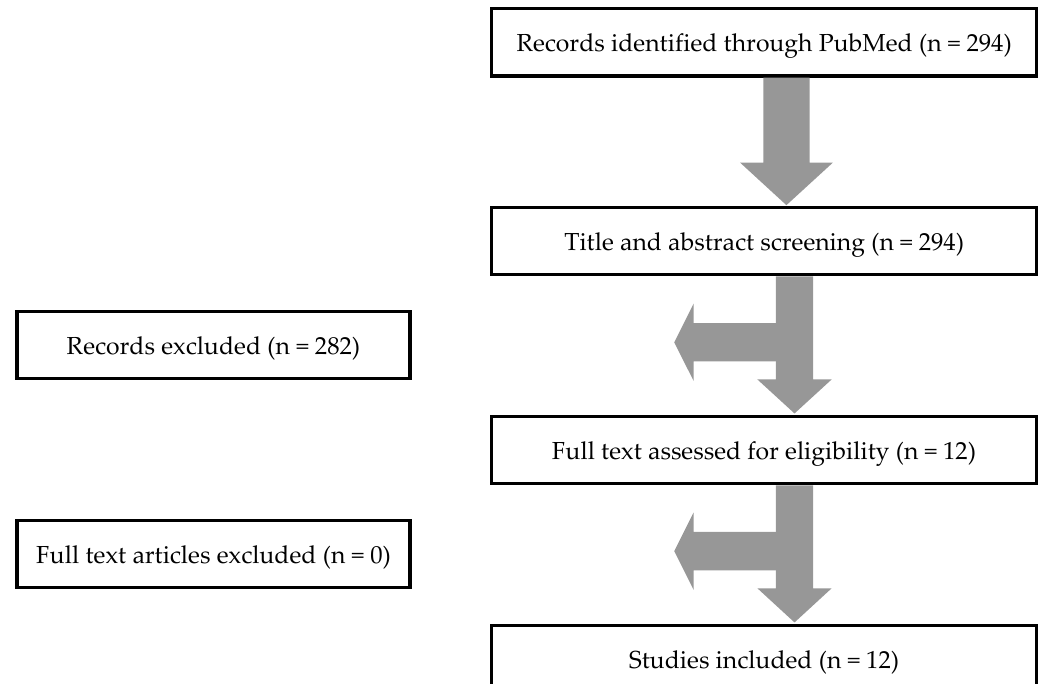
Figure 1. Preferred Reporting Items for Systematic Reviews and Meta-Analyses (PRISMA) flow Figure1. diagram.